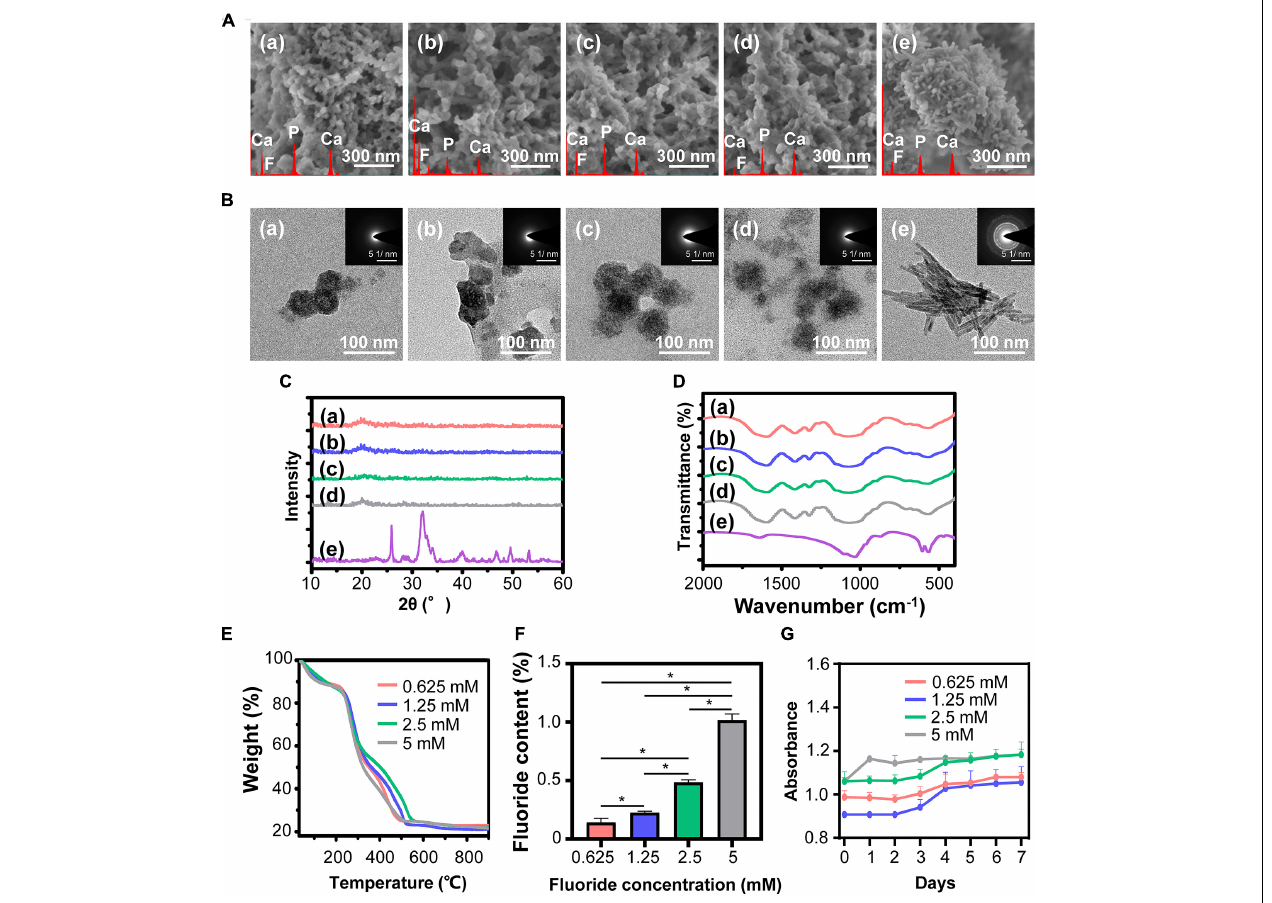
FIGURE 2 | Synthesis and characterization of FACP with different fluorine concentration. (A) SEM images, (B) TEM images and the corresponding SAED pattern, (C) XRD spectra, and (D) FITR spectra of FACP with different fluorine concentration. In A – D , the initial fluorine concentration of FACP was (a) 0.625, (b) 1.25, (c) 2.5, and (d) 5 mM. (e) Synthesized fluorine containing calcium phosphate without CMCS. (E) TGA result and (F) fluorine content of FACP. (G) OD profiles (650 nm) of FACP dispersion up to 7 days. Asterisk on top of each bar indicated statistically difference between groups ( p <